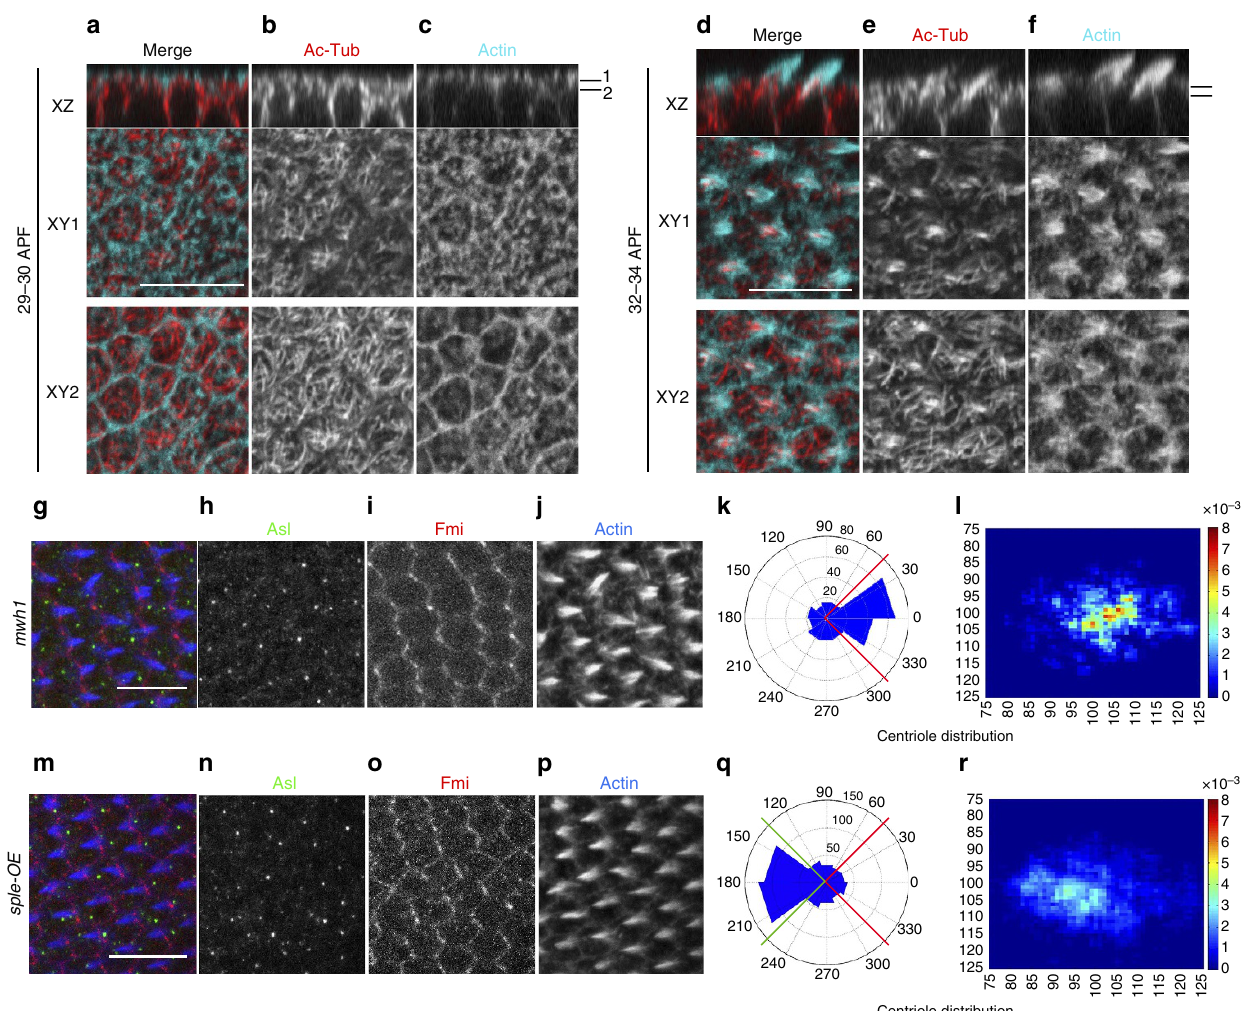
Figure 3 | Centriole localization relative to trichome position. ( a – c ) XZ and two XY optical sections of same wing area, showing polymerized actin (phalloidin, cyan) and acetylated tubulin staining (red, monochrome in b ). At 29h APF before actin-based hairs are formed, both actin and acetylated tubulin appear enriched at the apical portion of the pupal wing cells; two planes, apical ( XY1 ) and subapical ( XY2 ) are shown in the XY -axis (indicated in the XZ sections as black lines 1 and 2). ( d – f ) After hair formation (32h APF), acetylated tubulin is enriched at the base of each hair and within the polymerized actin structure. XZ and two XY planes, apical ( XY1 ) and subapical ( XY2 ) are shown in the XY -axis from the same; stainings as in a . ( g – l ) Centriole localization in the mwh 1 mutant is less polarized than wt (in 32h pupal wing cells; compared with Fig. 1v,w). Asl (green), Fmi (red) and phalloidin (blue) stainings and the respective monochromes are shown. k and l show centriole distribution quantifications in mwh 1 mutant, note shift to less polarized, central distribution most evident in heat map ( l ). ( m – q ) Overexpression of Sple (Sple-OE) causes reversal of cellular polarity and hair position, and accordingly also centriole positioning is inverted; quantifications in q , r . Asl staining position was used for quantifications in rosettes ( k , q ) and heat maps ( l , r ). Scale bar, 10 m m. Statistical analysis: centriole rosette diagrams, k versus Fig. 1w ( wt control): P o 0.001; q versus wt control: P o 0.0001 ( w 2